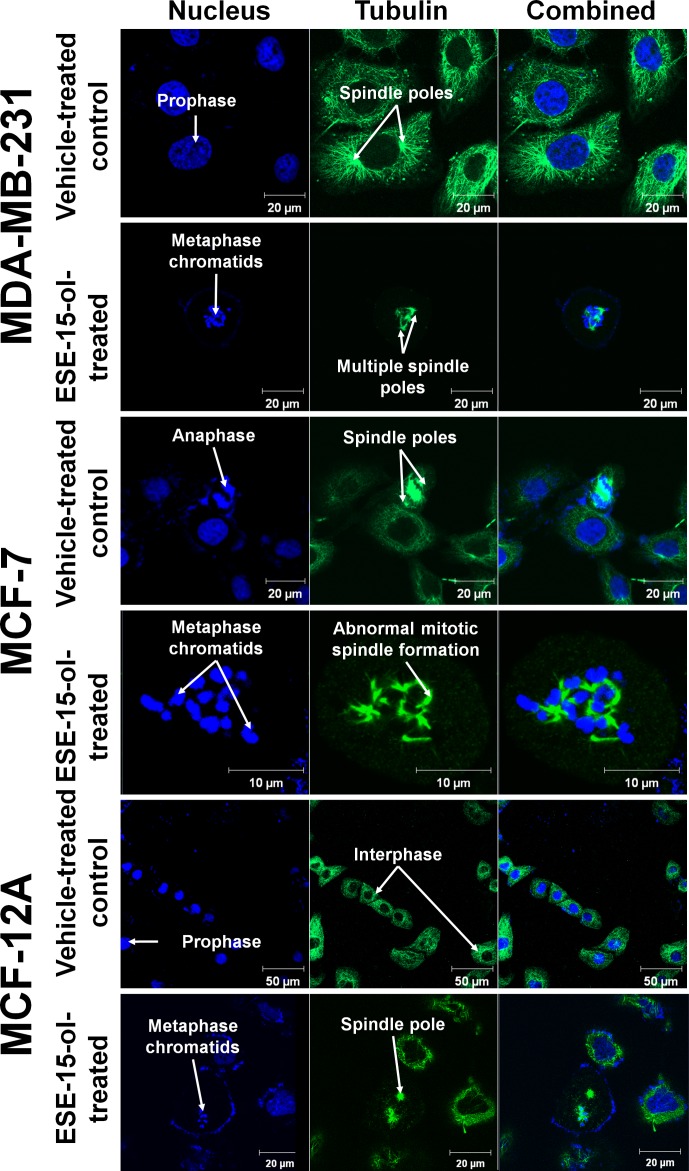
Vehicle-treated control and ESE-15-ol-treated cells stained with 4′,6-diamidino-2-phenylindole and Alexa-488 anti-tubulin after 24-h exposure.Vehicle-treated in MDA-MB-231, MCF-7 and MCF-12A cells show no signs of abnormal cell cycle completion formation. ESE-15-ol-treated cells show various degrees of abrogated cell cycling including abnormal mitotic spindle formation and multiple spindle pole formation during mitosis.